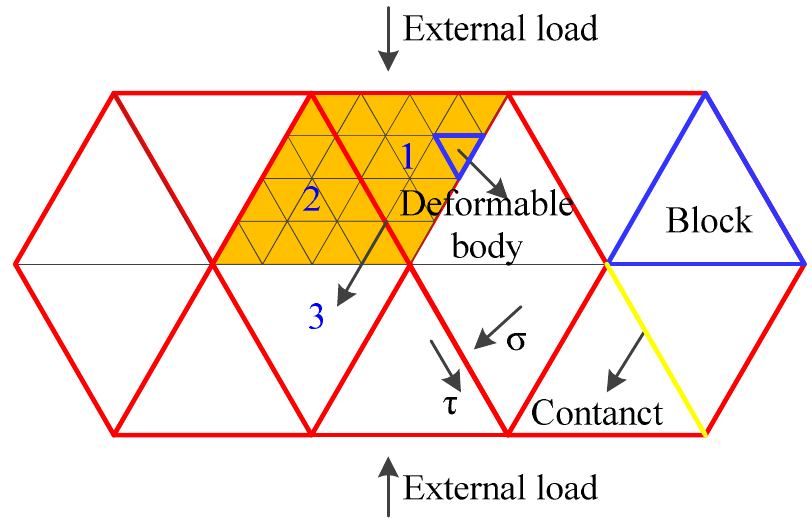
Figure 5. Mechanism of contact strength attenuation.